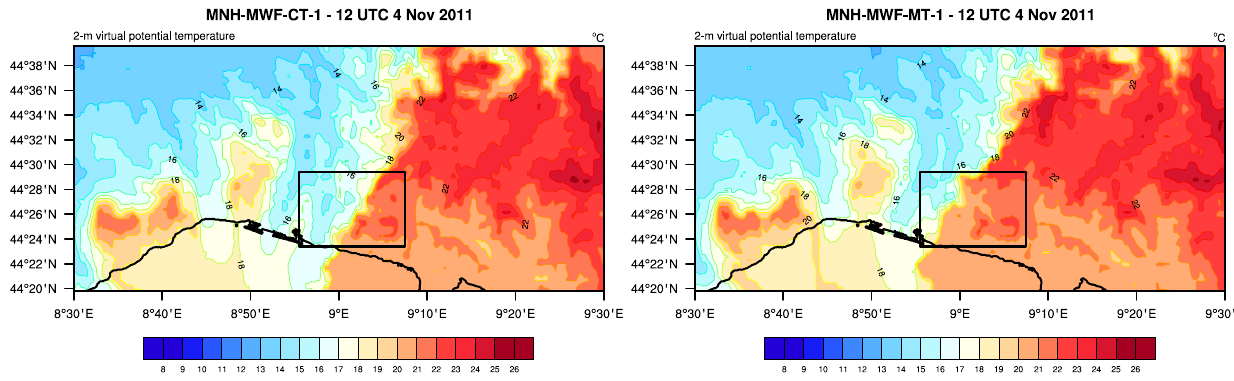
Figure 11. The simulated 2m virtual potential temperature (in ◦ C) for the MNH-MWF-CT-1 and MNH-MWF-MT-1 ensemble members at 12:00UTC on 4 November.